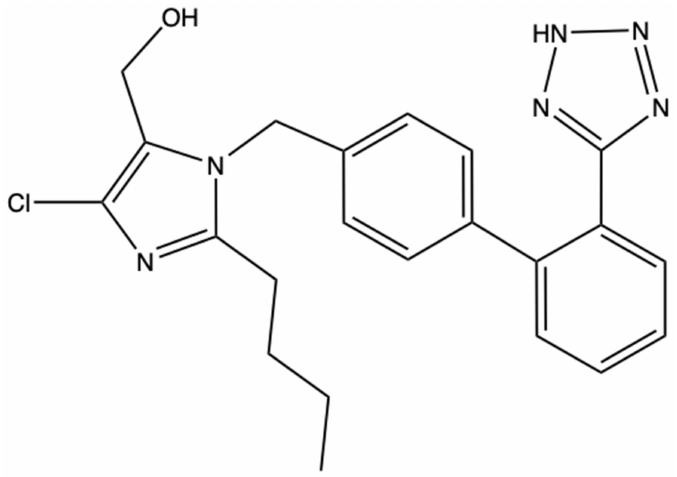
Figure 6. Molecular structure of